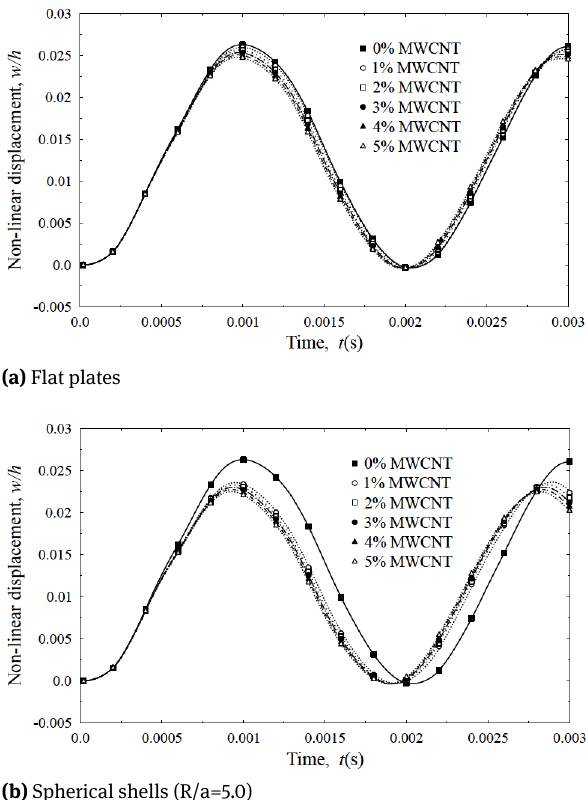
Figure 6: Nonlinear transient displacements ( w / h ) of MWCNT re- inforced composite flat plates and spherical shells ( q = 1.0 MPa, [0/90] s , V f = 0.8 , no cutout)